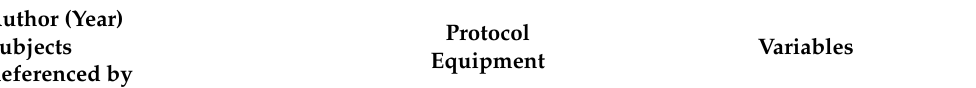
Table 4. Reliability articles cited in reviewed